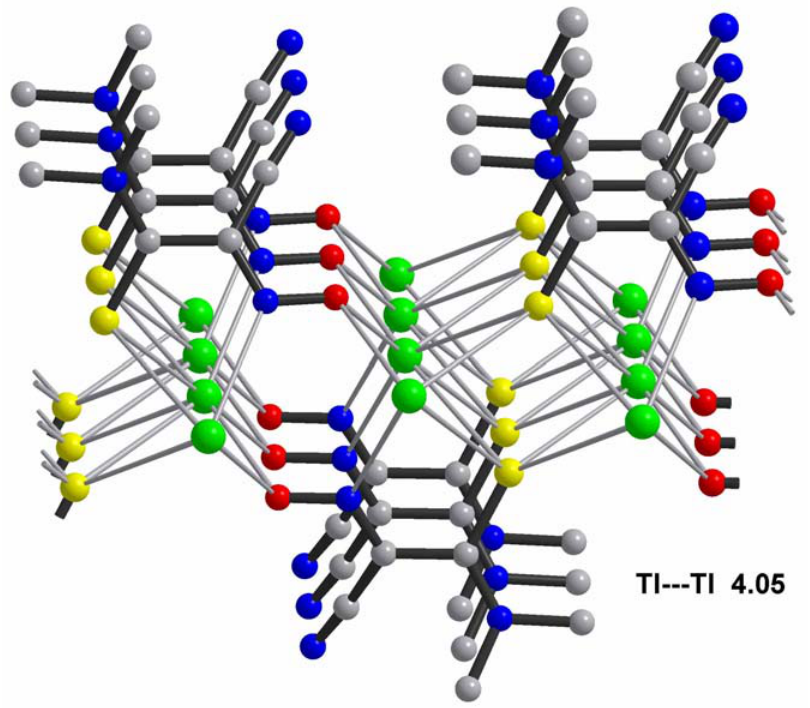
Figure 10. Organization of a layered type 2D coordination-polymeric structure of Tl(TDCO) by means of annealing of centrosymmetric Tl the nitroso group of neighboring anions into infinite stacks. Adjacent layers of complexes are connected only by van-der-Waals forces between N.N’-dimethyl-thioamde fragment.